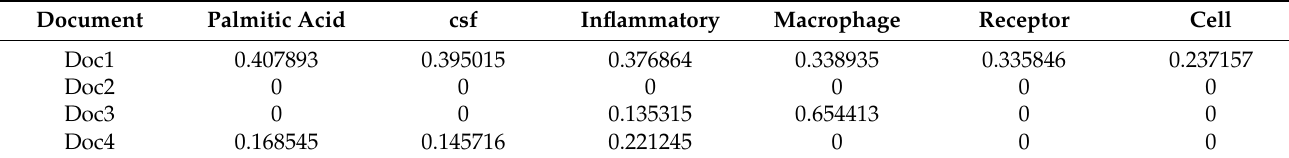
Table 3. Sample of TF-IDF document–keyword